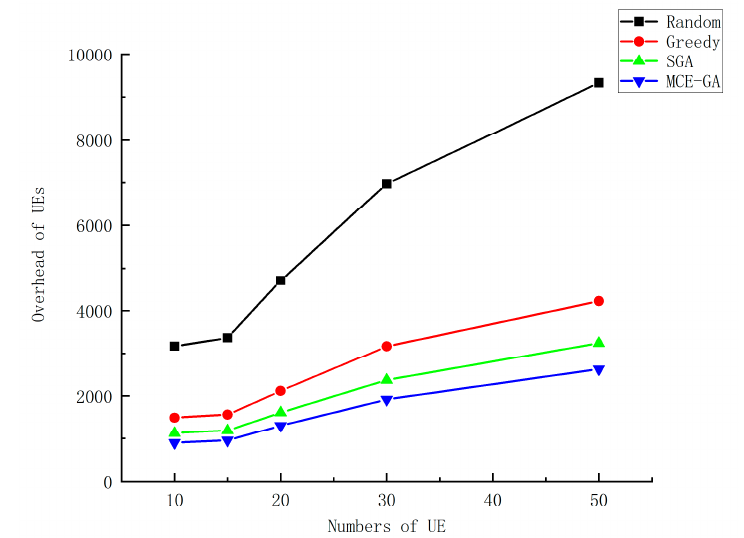
Figure 10. The execution overhead of different numbers of device.